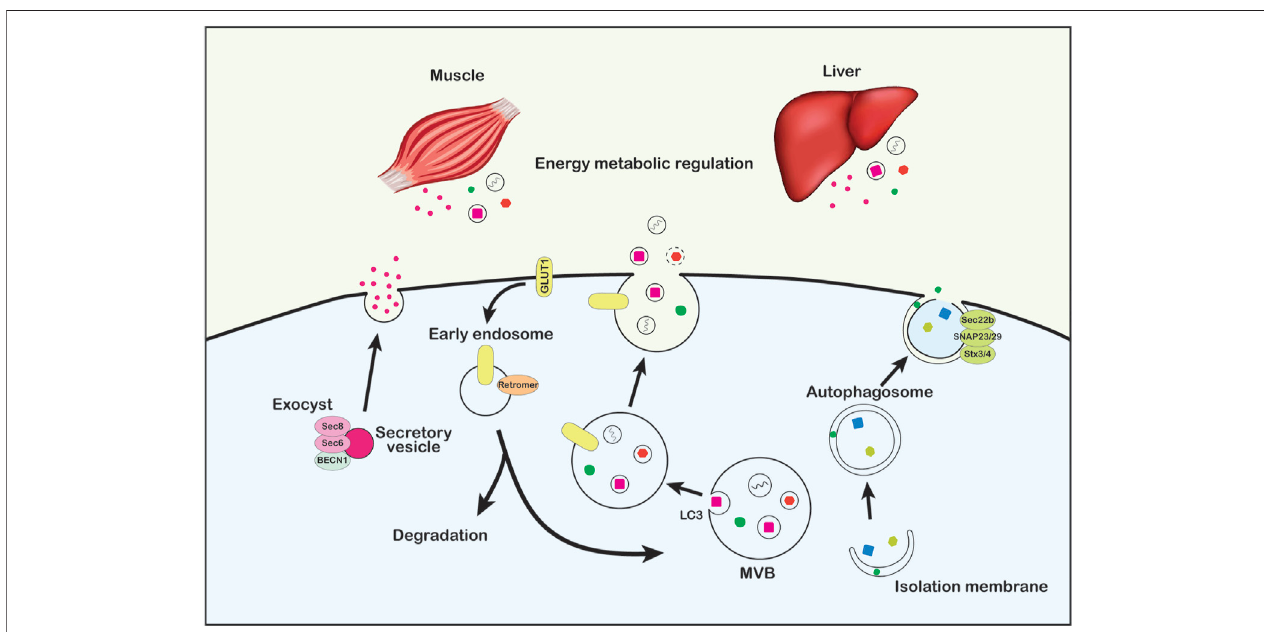
FIGURE2| Non-canonicalfunctionsoftheautophagymachineryinvesicletraf fi ckingandsecretion.ATGproteinsregulatesystemicmetabolicandenergybalance via non-degradative functions in vesicle traf fi cking and secretory protein release, including adiponectin secretion through direct interaction between BECN1 and the exocyst protein (left), retromer-driven GLUT1 recycling and ATG5- and LC3-dependent exosome secretion through the endosomal and MVB pathway (middle), and secretory autophagy (right).